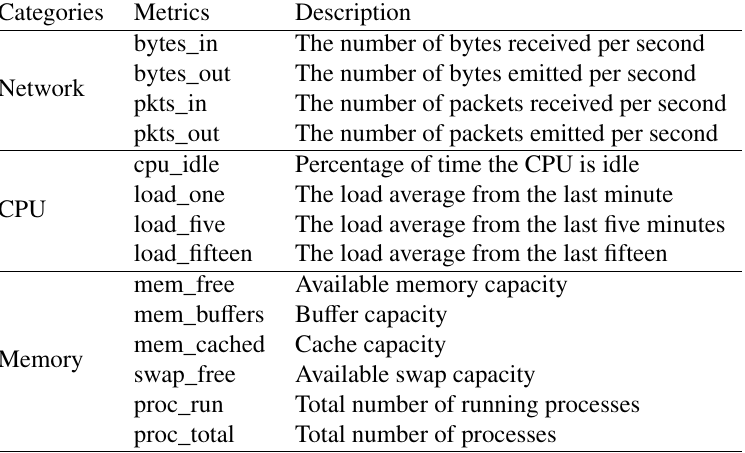
Table 1. Metrics used in the experience